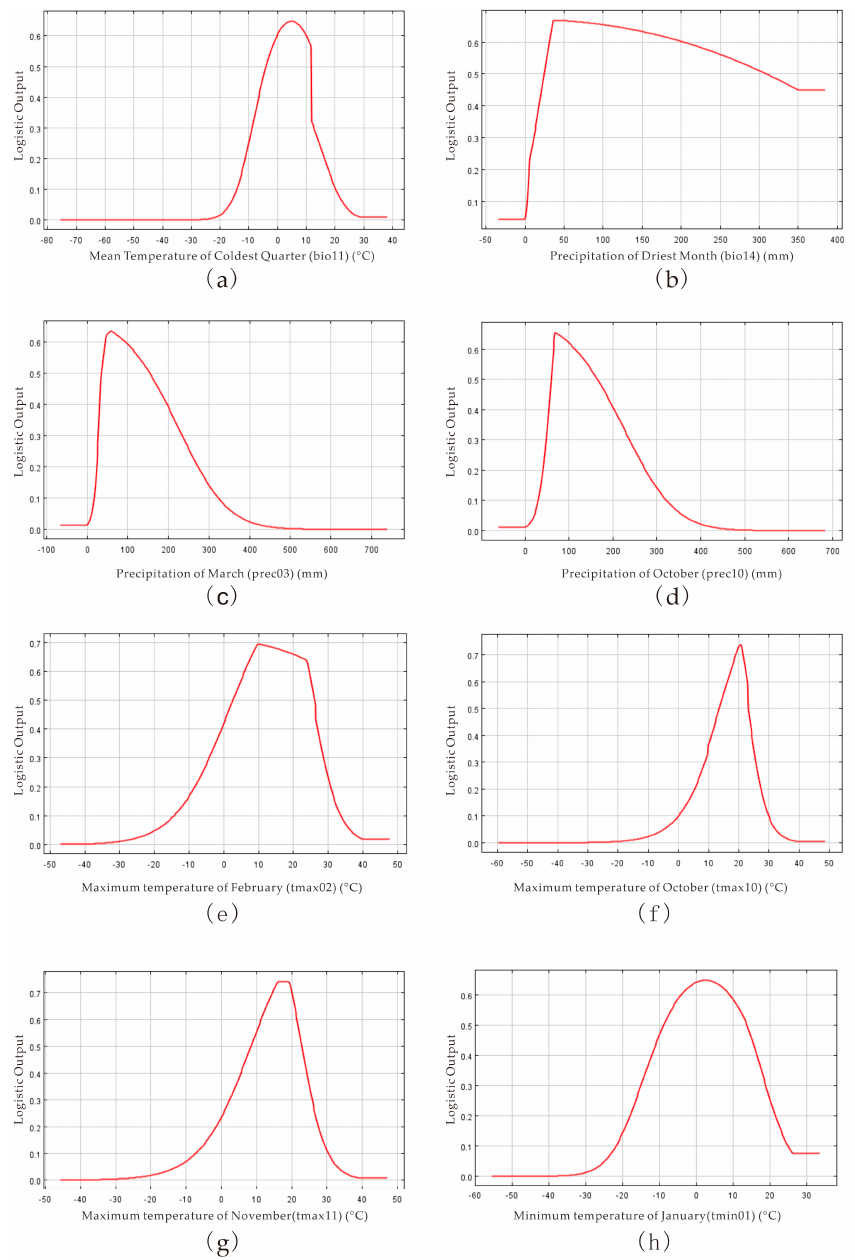
Figure 5. Relationship between distribution area of suitable areas and dominant climate variables (( a ) mean temperature of coldest quarter; ( b ) precipitation of driest month; ( c ) precipitation of March; ( d ) precipitation of October; ( e ) maximum temperature of February; ( f ) maximum tempera- ture of October; ( g ) maximum temperature of November; ( h ) minimum temperature of January) of M. fructicola .